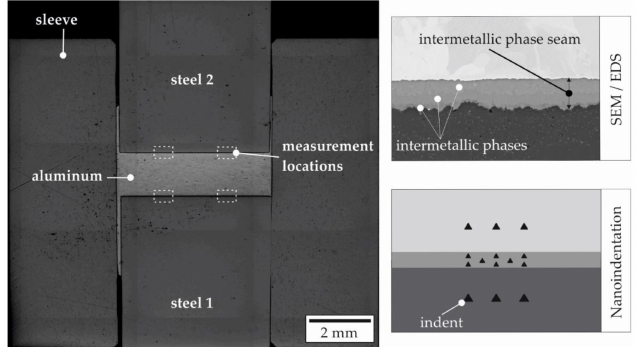
Figure 2. Schematic representation of a formed specimen with highlighted positions of the scanning electron microscopy (SEM) and nanoindentation